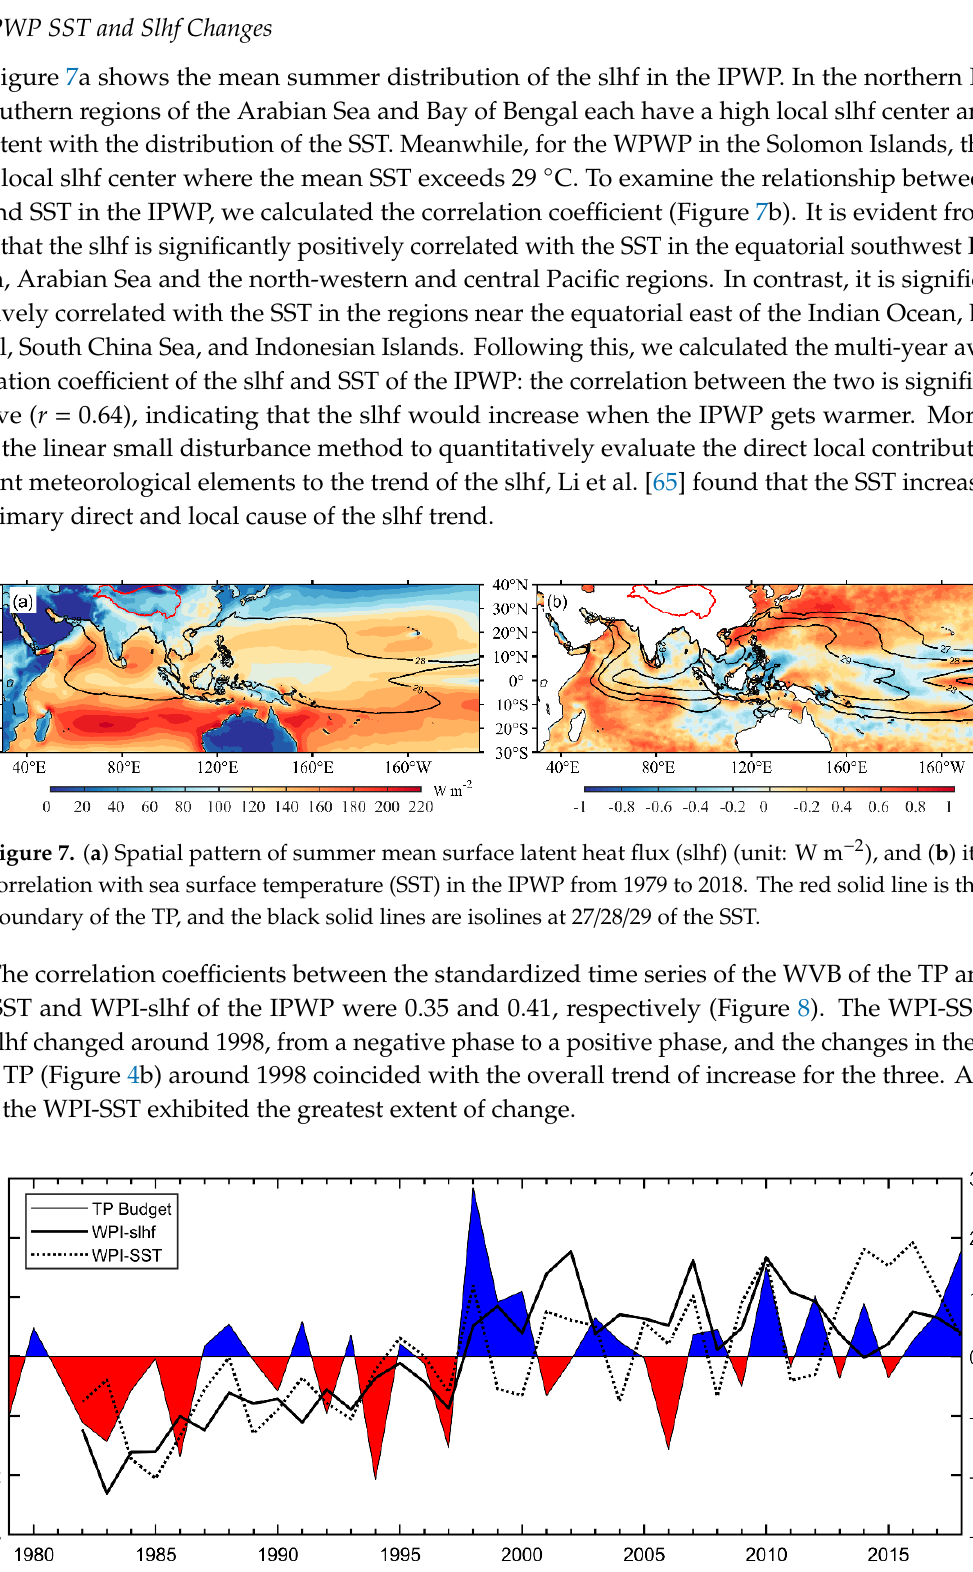
Figure 8. The standard time series of summer WVB in the TP (the shaded area) and the warm pool index (WPI)-slhf (solid black line) and WPI-SST (dashed black line).